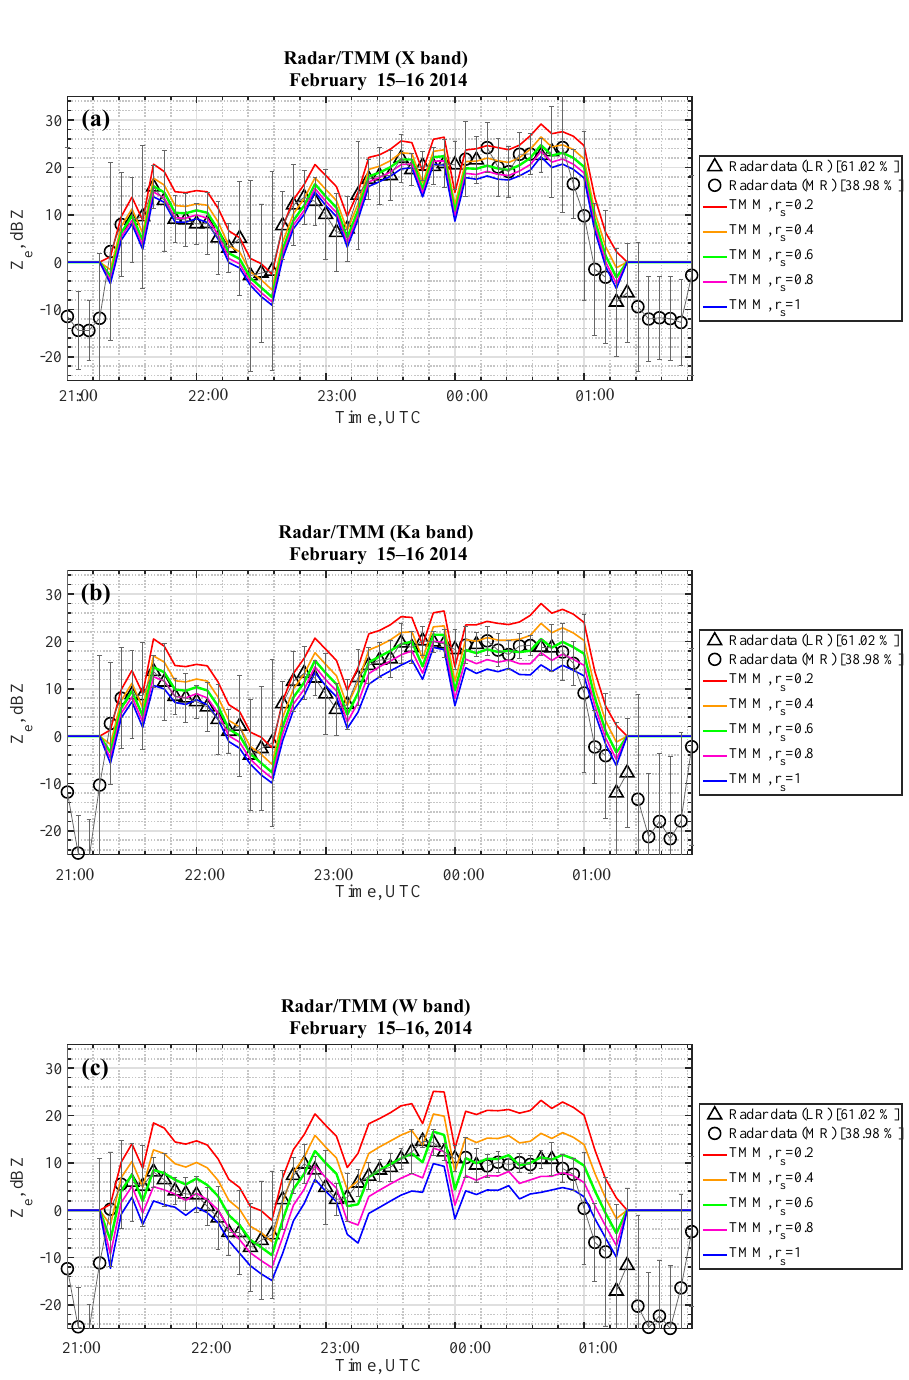
Figure 9. Same as Fig. 8, but for 15/16 February 2014, 21:00–01:48UTC (LR and MR snowfall in black triangles and circles, respectively).